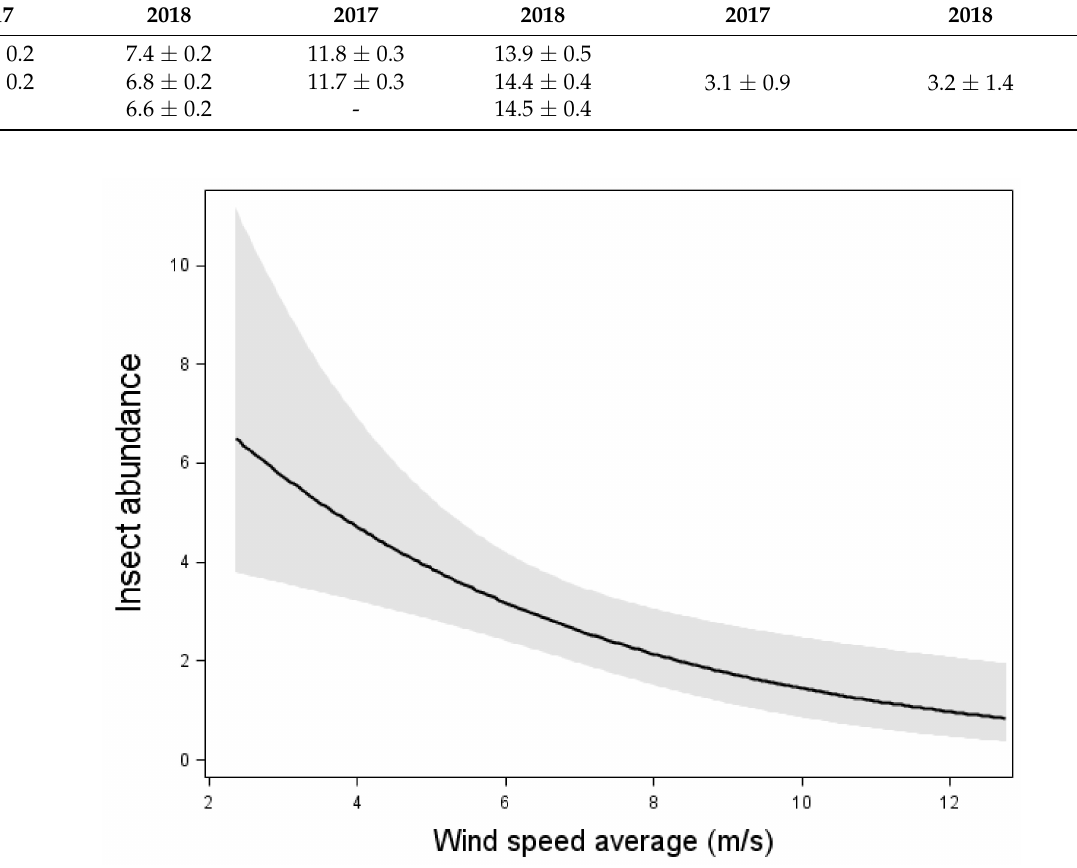
Figure 1. Relation between insect abundance and mean wind speed. Results from multiple Poisson- regression, where the insect abundance was the response variable. Relation, test-variable and p -value are shown for wind speed, which was the only significant variable in the model with the lowest AIC value. The line shows the mean value and dark area shows 95% confidence interval. n = 105